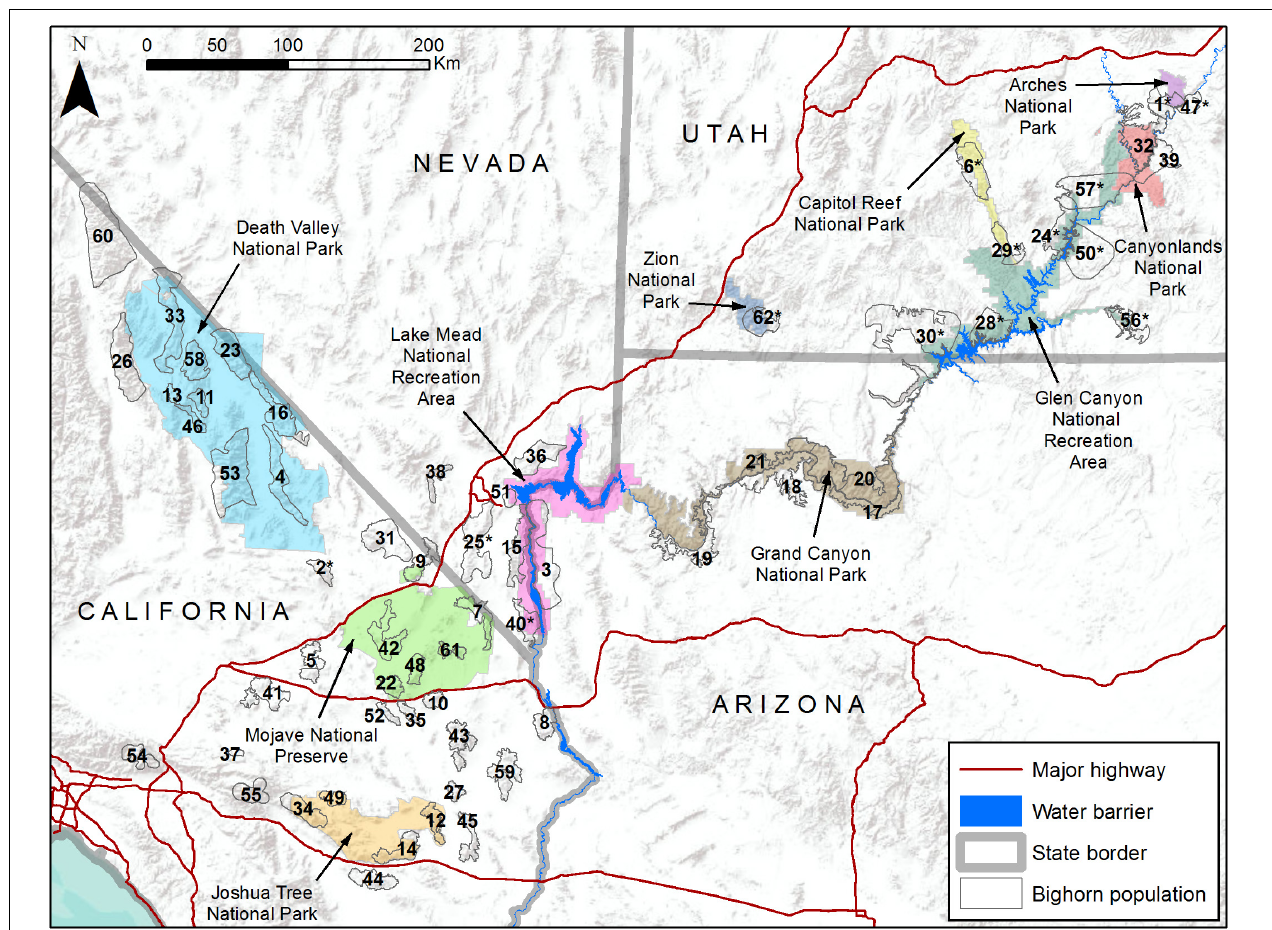
FIGURE 1 | Map of study area including 10 National Park Service units (colored polygons) and 62 desert bighorn sheep populations (numbered hollow gray polygons). See Table 1 for names of populations associated with numbered